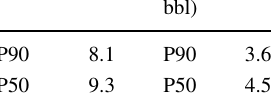
Fig. 12 Contribution toward total oil by each subunit, for the yield cutoff of 60 mg HC/g rock Table 6 Probabilistic result for the yield cutoff of 60 mg HC/g rock, considering the sum of subunits L1, L3, L5, L6 and